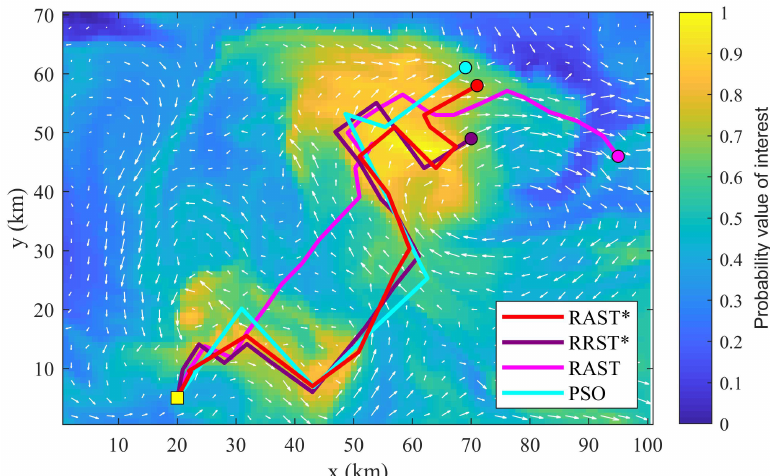
Figure 3. Illustration of optimized paths produced by RAST*, RRST*, RAST, and PSO over a scientific interest area without obstacles. (Scenario 1) The utility map denotes the probability value of scientific interest (blue = low scientific interest, yellow = high scientific interest). White arrows represent variable ocean